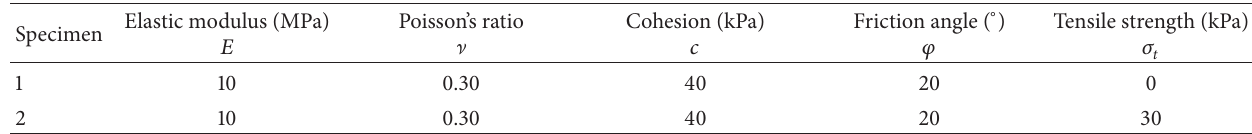
Table 1: Physical-mechanical parameters of material.